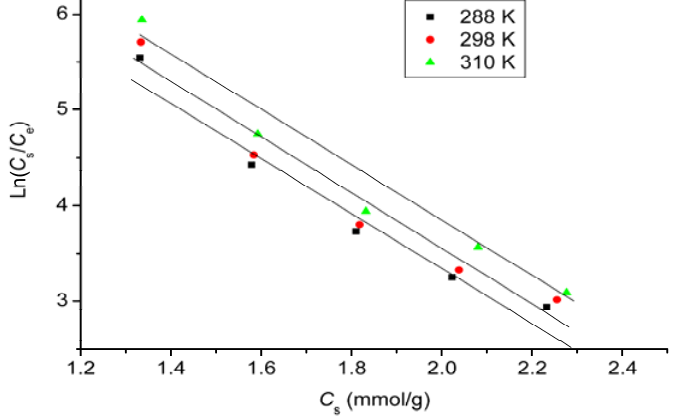
/ C vs. 1/ T for DOX adsorbed by e e